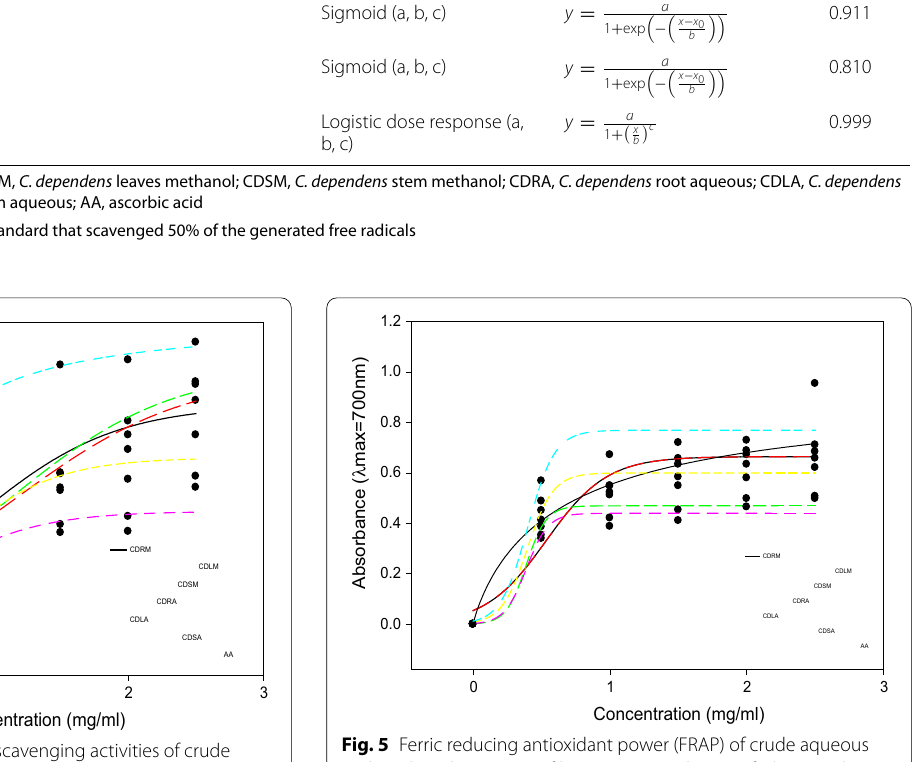
Table 6 Threshold inhibitory concentration (IC on hydrogen peroxide radicals Extracts